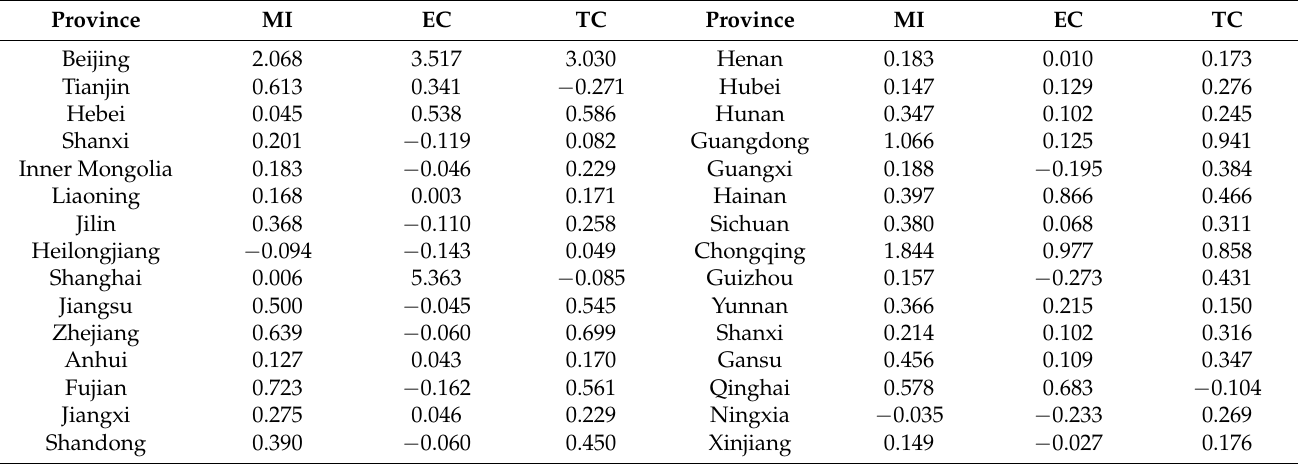
Table 3. Average annual growth rates of MI, EC and TC from 2000 to 2019 from the carbon sink perspective